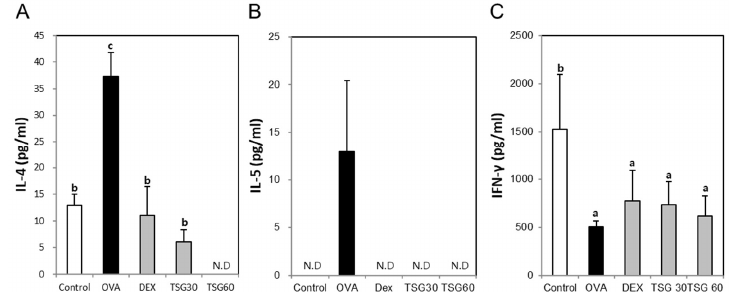
Figure 4. The effects of TSG on Th1-mediated cytokine and Th2-mediated cytokine in BALF. ( A ) IL-4, ( B ) IL-5, and ( C ) IFN-gamma were measured by enzyme-linked immunosorbent assay (ELISA). Group data are expressed as means ± SD for five mice per group. a, b, and c: The means not sharing a common letter are significantly different between groups at p < 0.05 as measured by one-way ANOVA with Duncan’s multiple-range test.